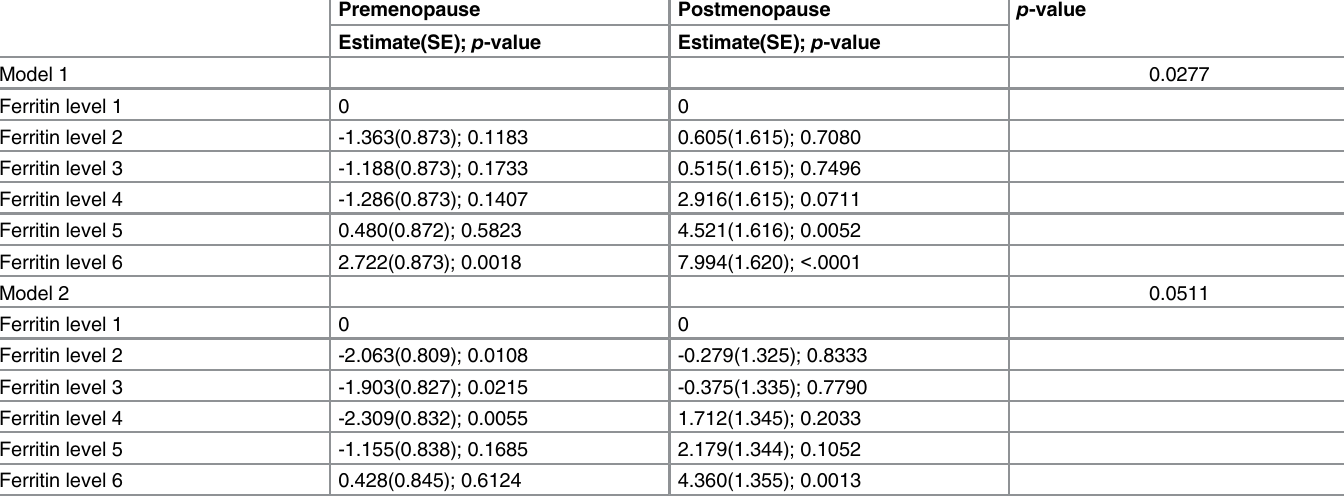
Table 7. Estimated regression coefficient for fasting glucose by serum ferritin